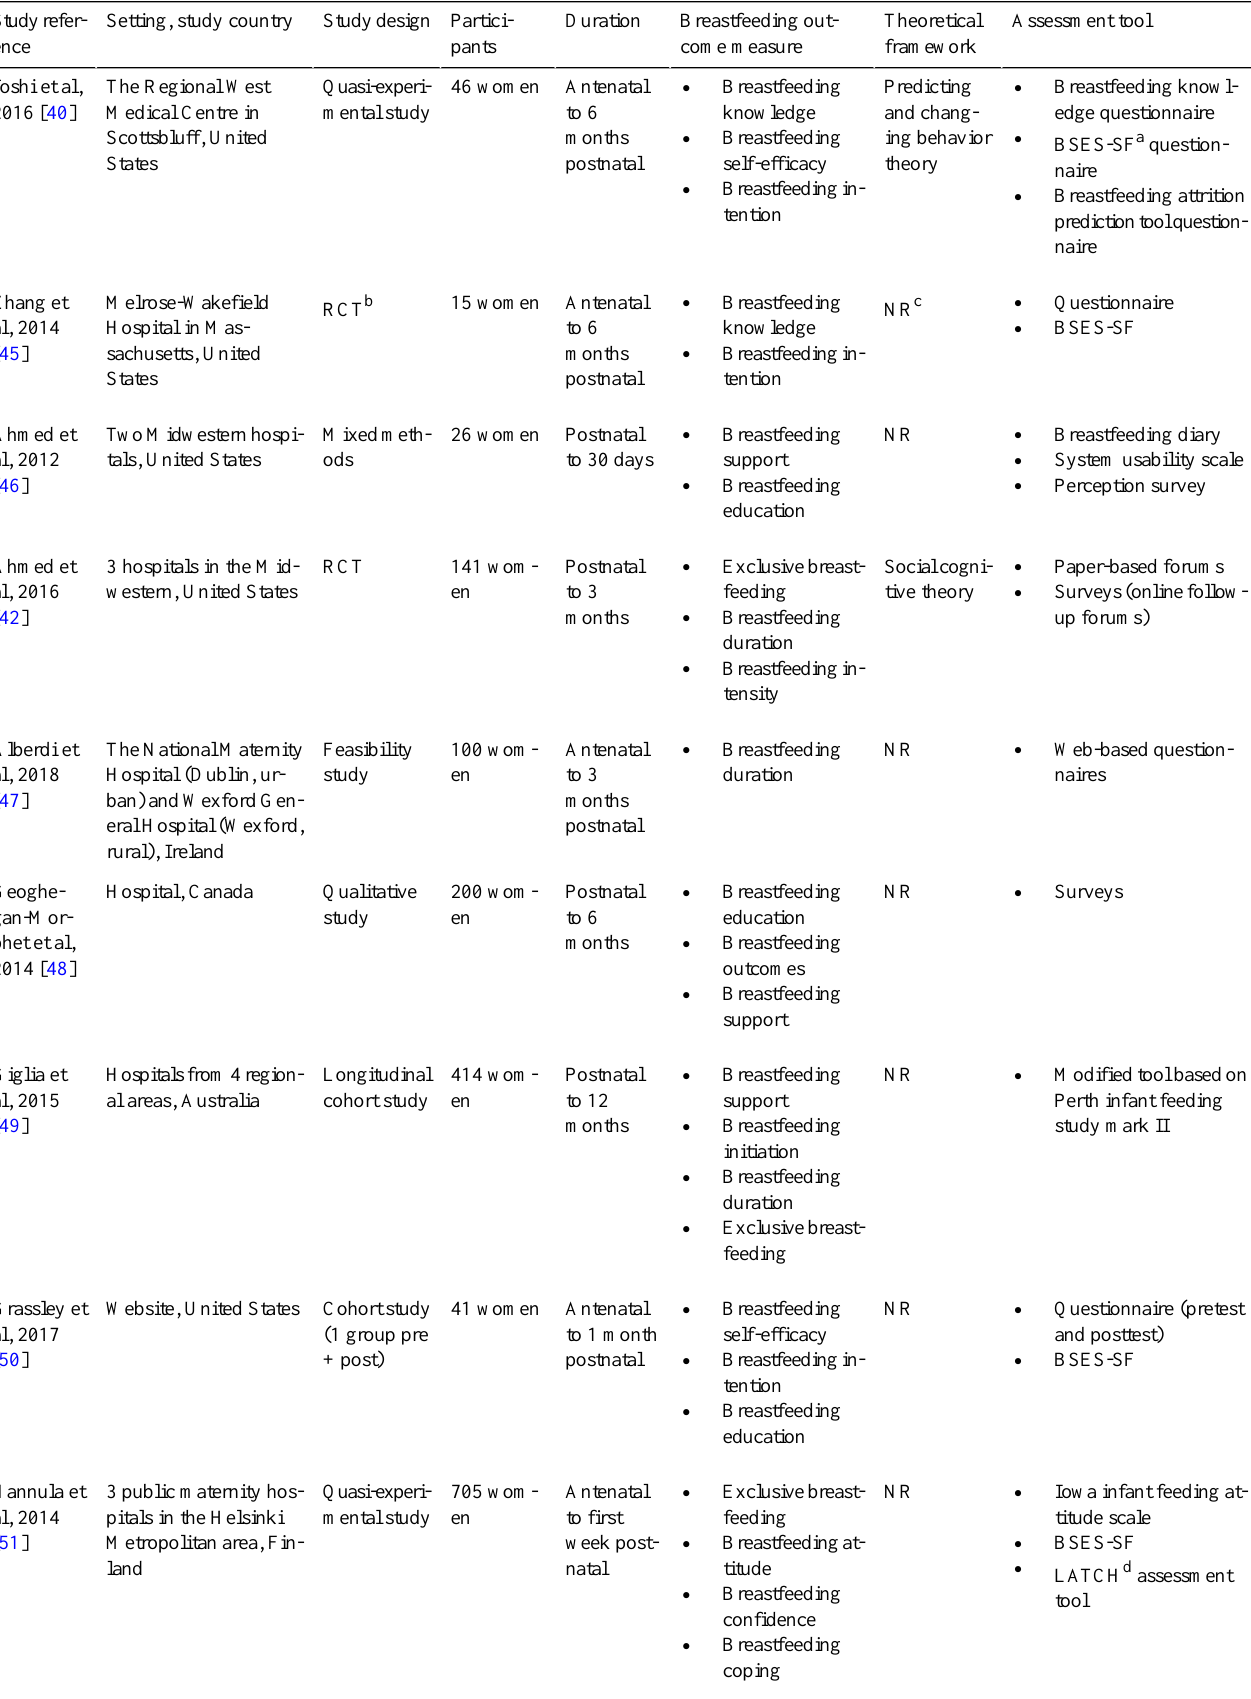
Table 1. Characteristics of included